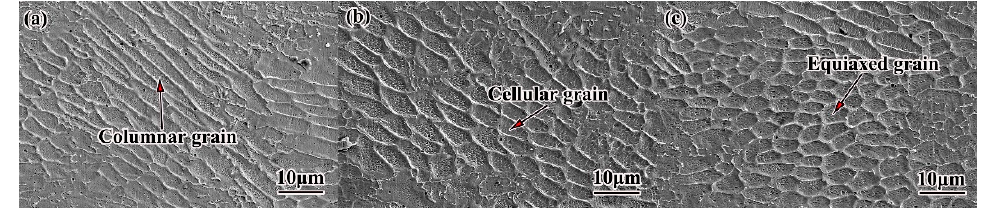
Figure 6. SEM image of specimen cross-section: ( a ) columnar grain; ( b ) cellular grain; ( c ) equiaxed grain.